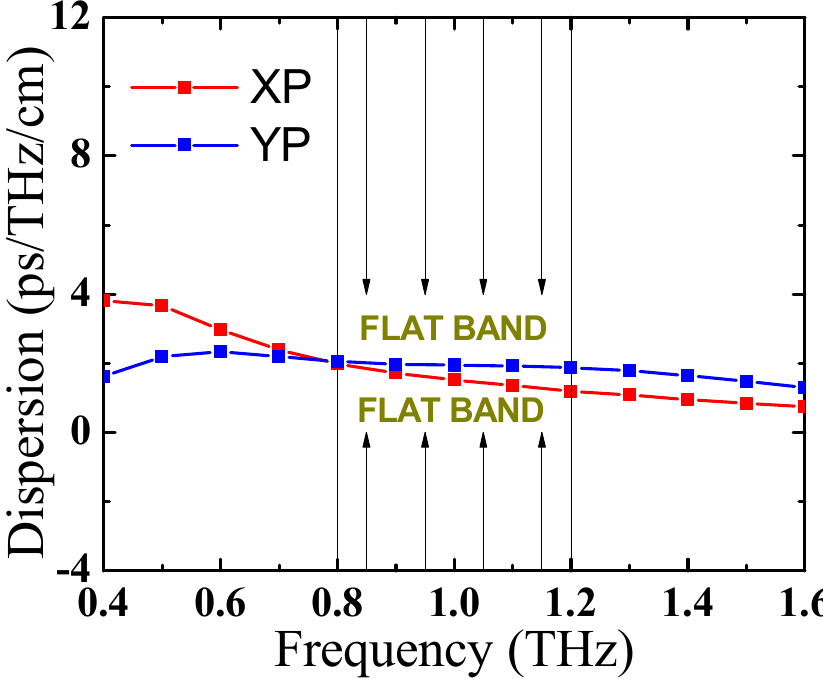
Figure 10. Dispersion profile of the QE design.